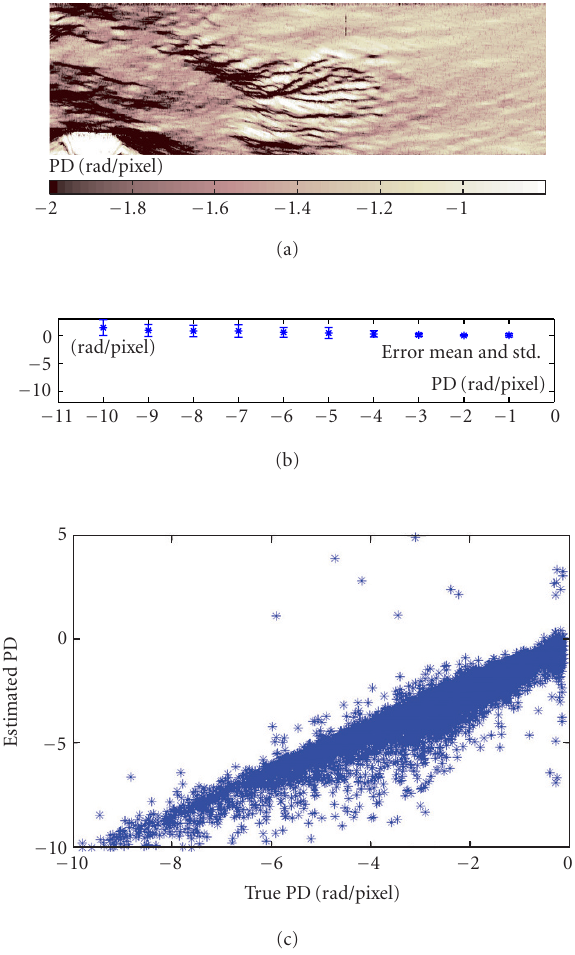
Figure 11: (a) PD estimated with all interferograms pairs and the application of the CB filtering with respect to the true topography. (b) The associated error plot (mean and standard deviation of the error). (c) The scatter plot of the estimated PD versus the true